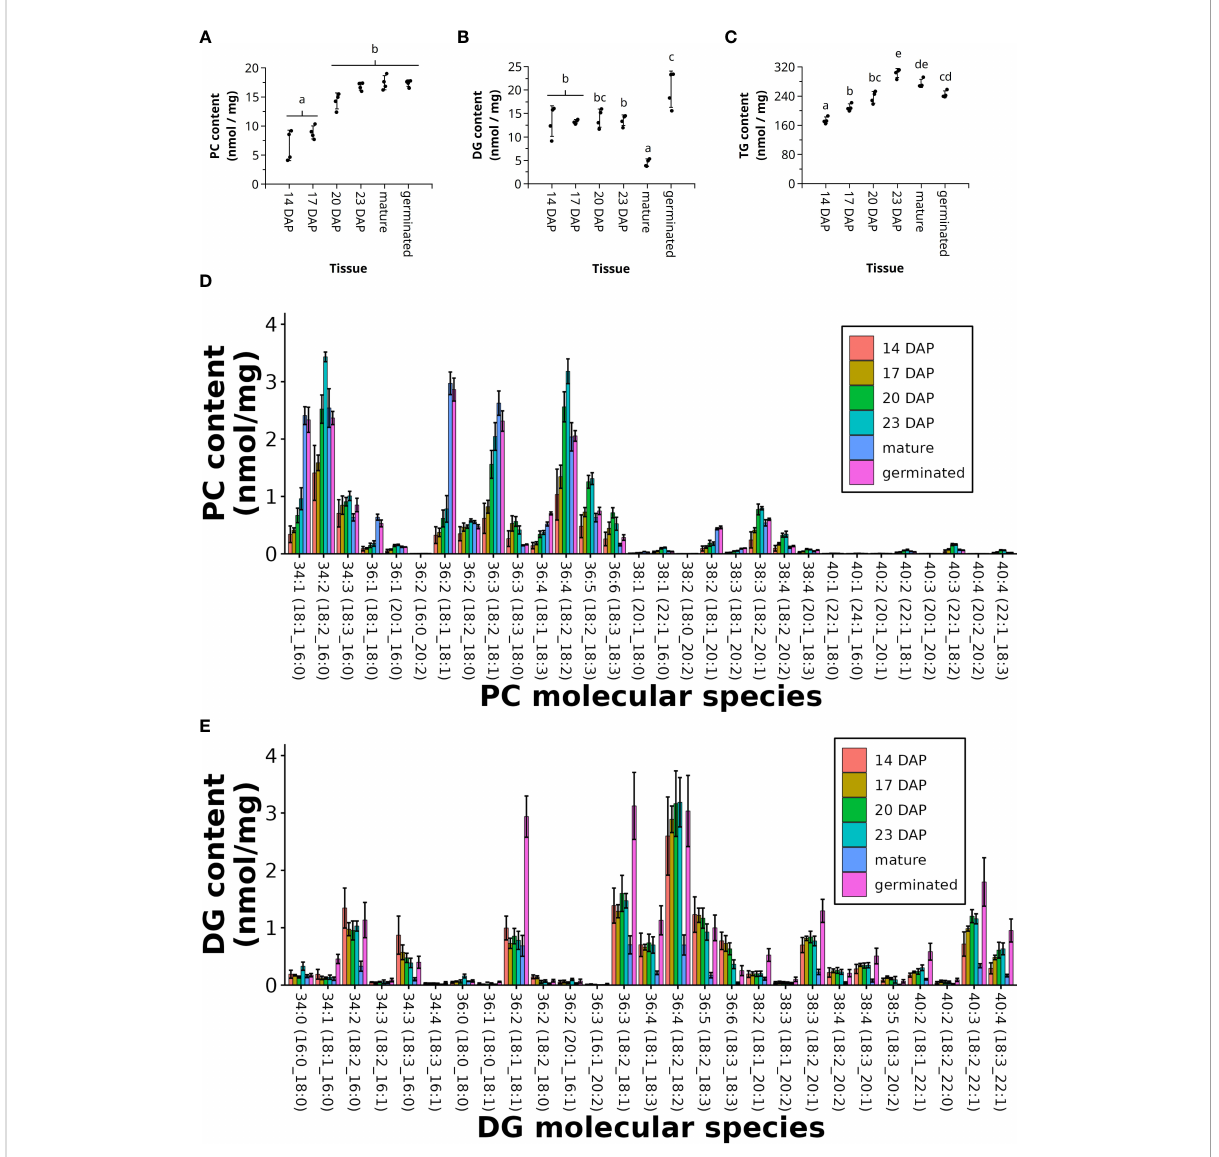
FIGURE 6 Lipidomics of developing pennycress seeds. Total sum of PC (A) , DG (B) , and TG (C) , and the individual molecular species of PC (D) and DG (E) from developing pennycress seeds at 14, 17, 20, and 23 days after pollination (DAP), as well as mature and germinated seeds. (n = 4; one-way ANOVA; Tukey test, p <